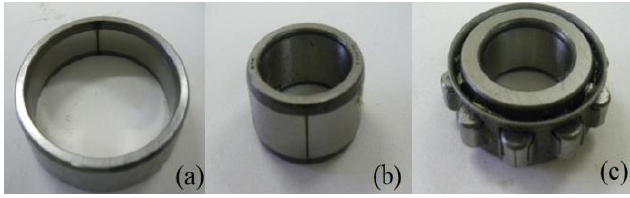
Figure 3. Bearing defects. ( a ) Outer-race defect; ( b ) Inner-race defect; ( c ) Roller